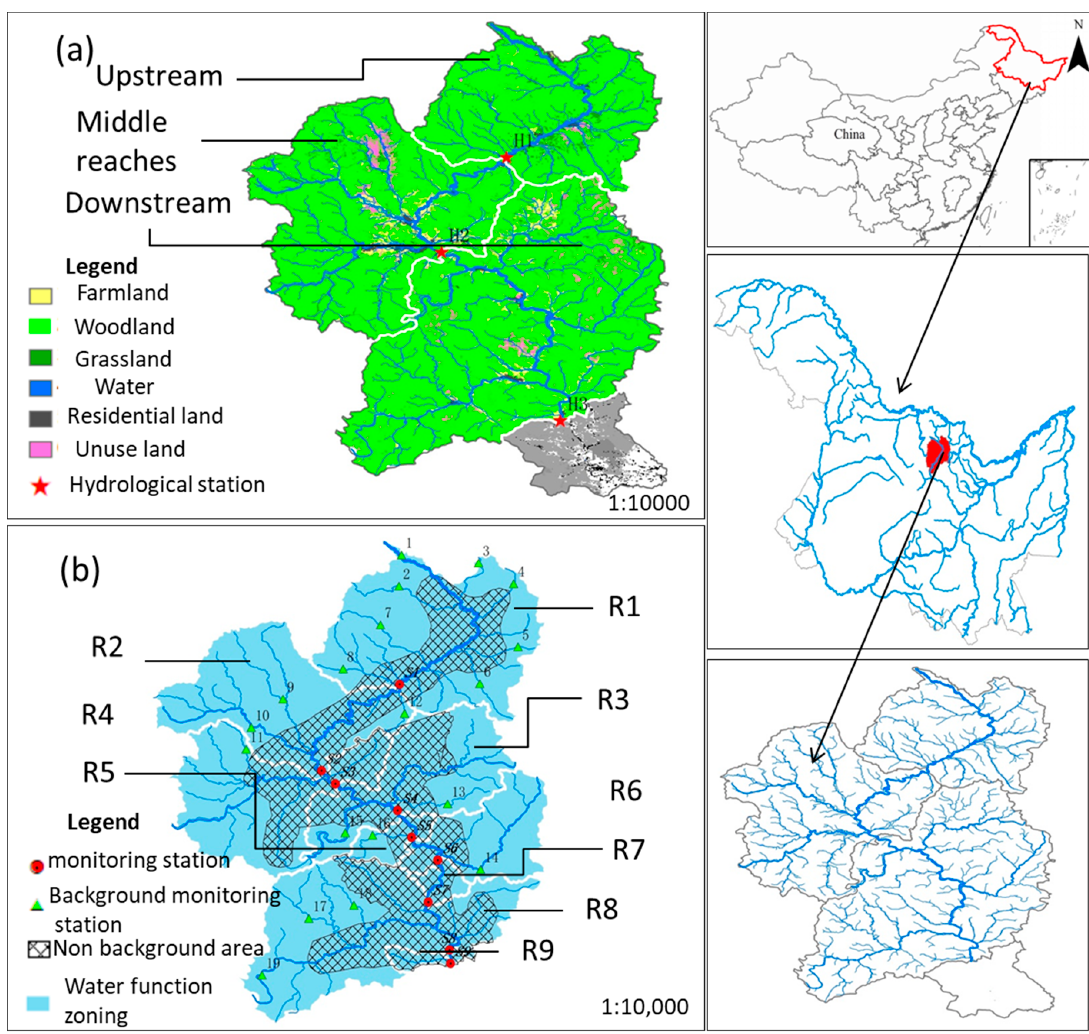
Figure 1. Partition of sampling sites in the Tangwang River Basin according to land-use types. ( a ) The river is divided into upper, middle, and lower reaches according to the control area of hydrological stations (H1–H3); ( b ) monitoring stations for water quality in water function zones (R1–R9); background monitoring stations (1–19) were used to monitor water quality in areas where human activity is scarce; Non-background areas include areas with high intensity of human activity; reference standard (GB / T50594-2010) for the division of water function